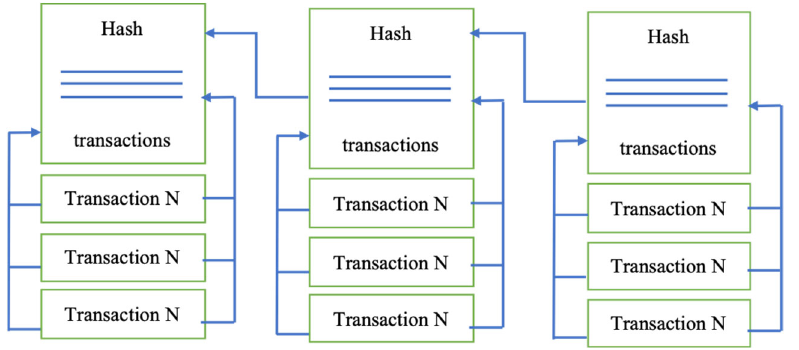
Figure 2. Model of a Blockchain data structure.